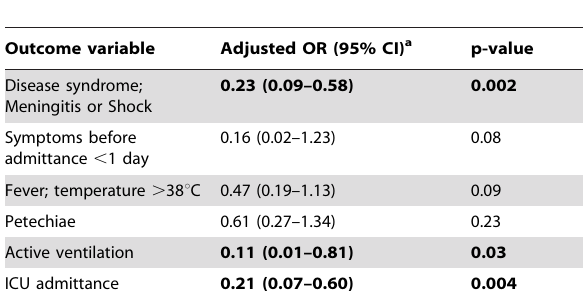
Table 5. Multivariable analyses for impact of infection with lipid A variants on different outcome